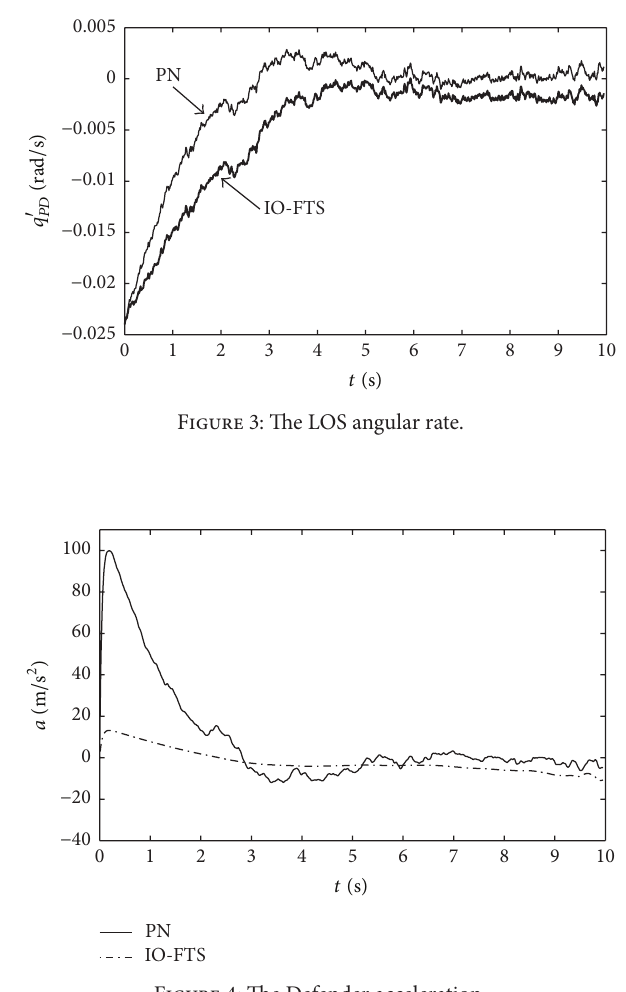
Figure 4: The Defender